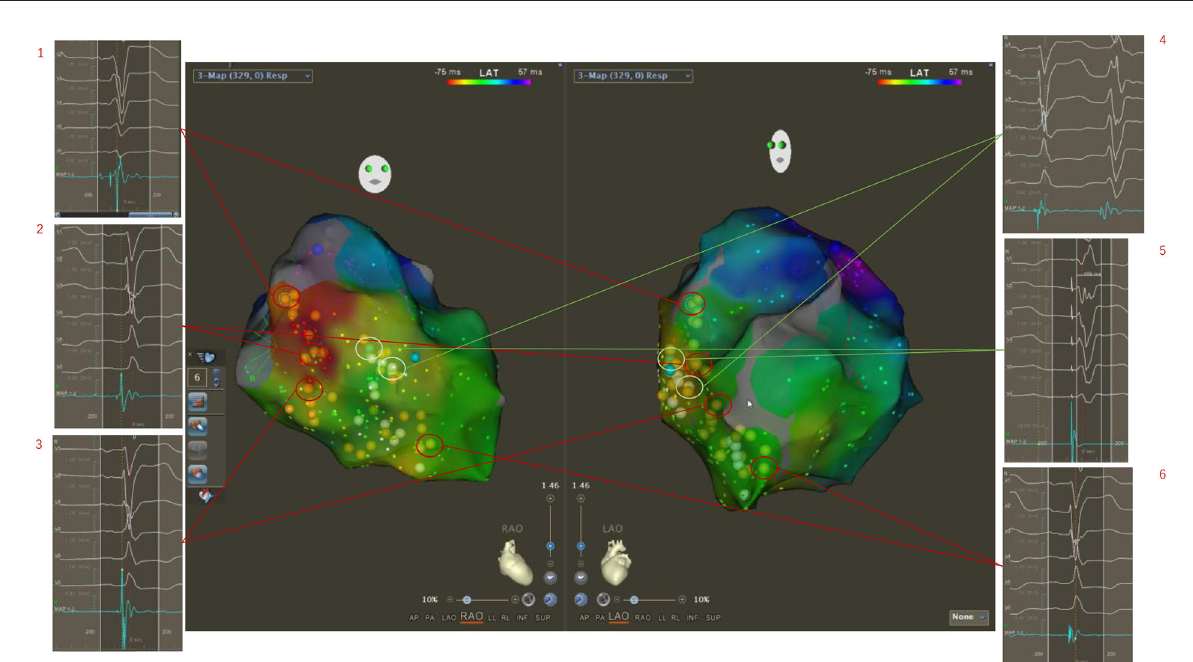
FIGURE3 Three-dimensional electroanatomical mapping showed normal conduction of the left bundle branch although ECG showed LBBB pattern. The potentials of His and the left bundle branch were mapped from the bottom to the apex of the left ventricular septum (1, 2, 3, 6). The occasional mechanical stimulation in the left bundle branch area induced the subsequent wide premature ventricular contraction (4). Then, the electrical stimulation was performed in the upper middle area of the left bundle branch, and a wide rSR morphology in surface lead V1 was seen, which indicated the left bundle branch was normal (5). Classical CRT with coronary venous pacing was planned.